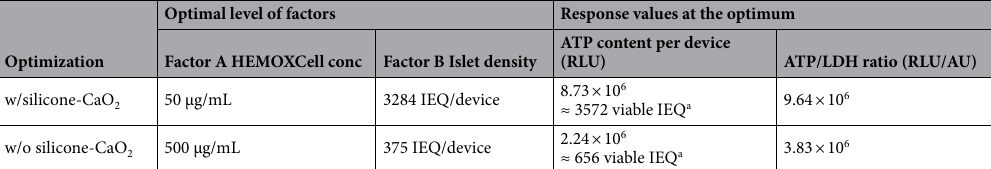
Table 6. Multi-response BAP optimization under hypoxia with and without silicone-CaO 2 . a Number of equivalent viable and dead MPIs interpolated from the ATP content standard curve (Supplementary Fig. 3).